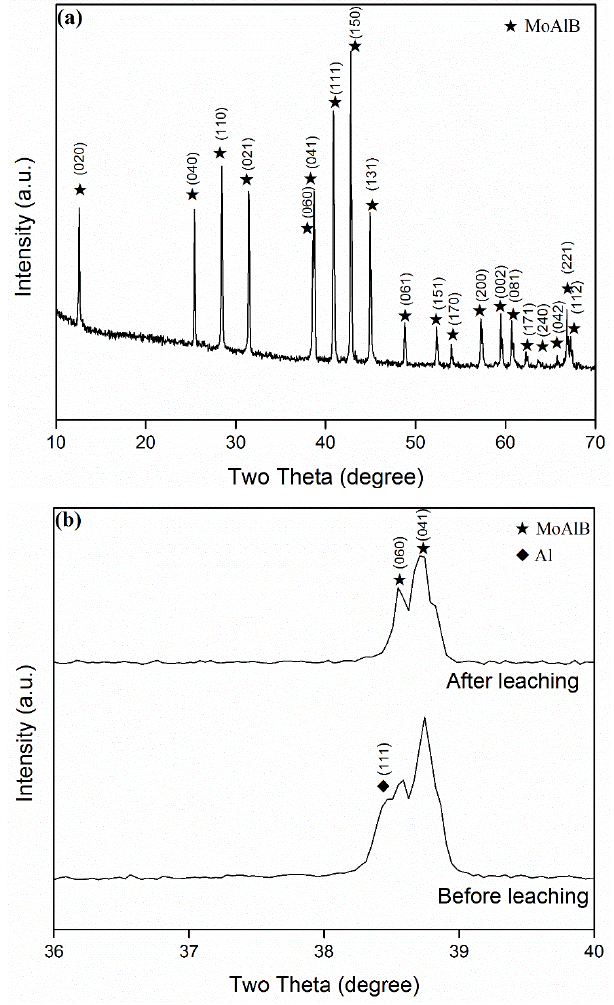
Figure 5. ( a ) XRD pattern of the sample after 6 h of firing at 1000 °C and the subsequent acid leaching, and ( b ) comparison of XRD patterns (within 36–40°) of the samples before and after acid